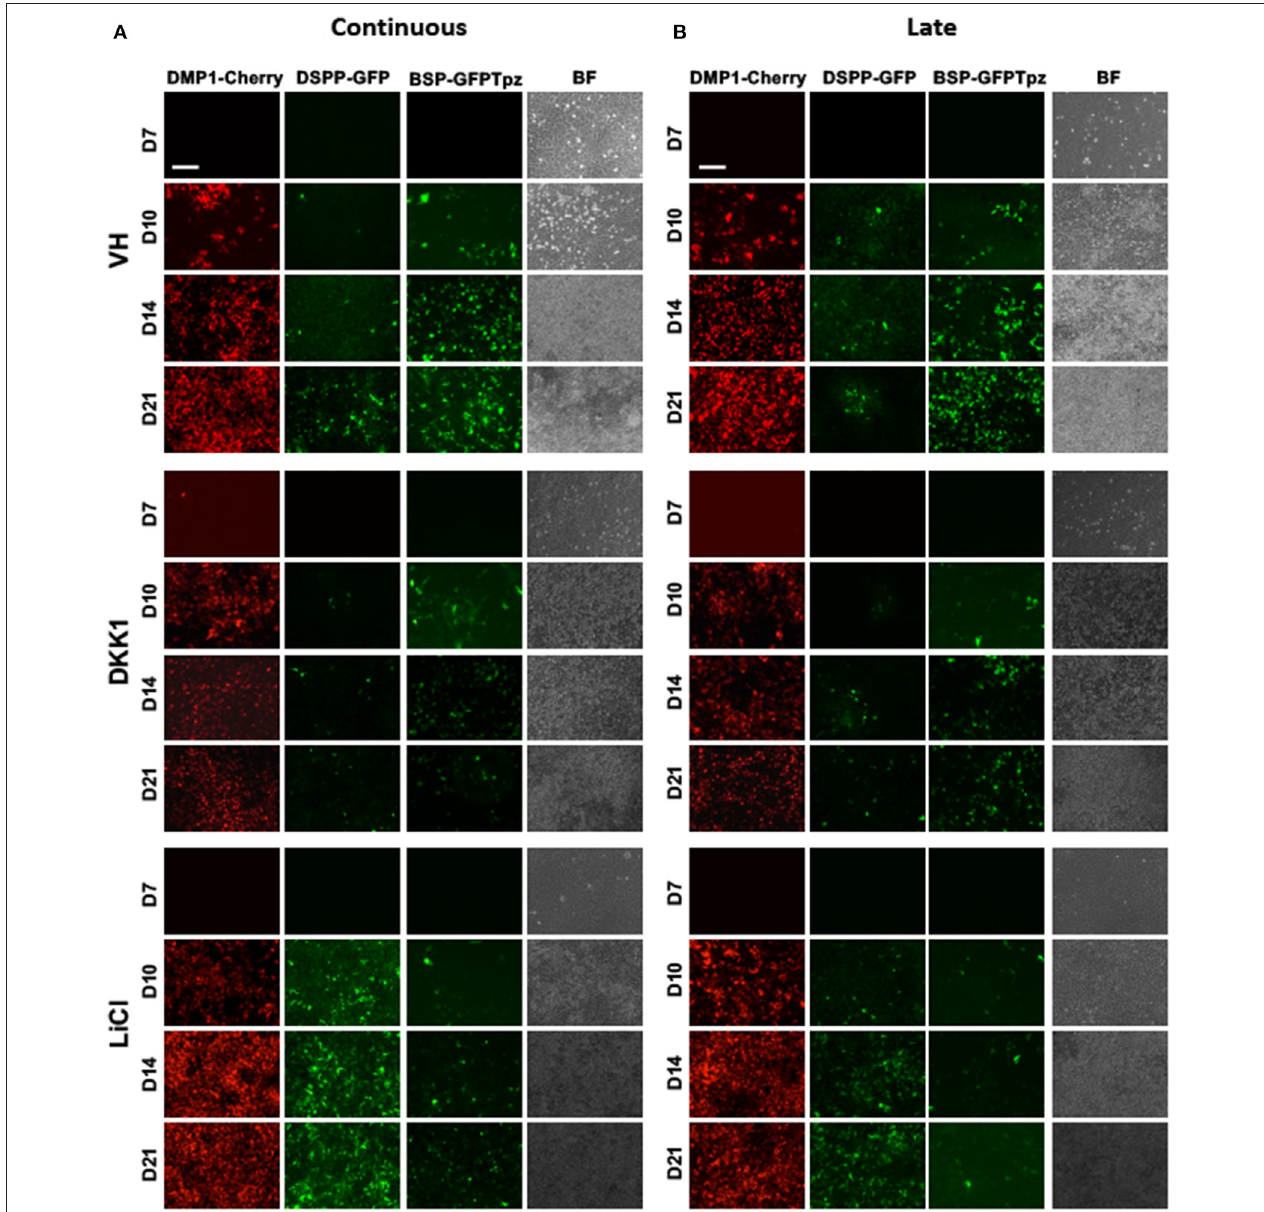
FIGURE 4 | Effects of continuous and late exposure of LiCl and DKK1 on tissue- and stage-specific reporters by epifluorescence imaging. Primary pulp cultures were treated continuously between days 3 and 21 (A) and late between days 7 and 21 (B) with VH (0.1% BSA), DKK1 (50ng/ml) and LiCl (10mM). (A,B) Representative images of the cultures from DMP1-Cherry/DSPP-Cerulean and BSP-GFPtpz transgenic mice treated with VH, DKK1, and LiCl continuously (A) , and late (B) analyzed under brightfield (BF) and epifluorescent light for the detection of DMP1-Cherry, DSPP-GFP, and BSP-GFPtpz. Continuous and late exposures to LiCl increased DMP1-Cherry and DSPP-GFP expression, which were decreased in DKK1 treated cultures. Continuous and late LiCl and DKK1 treatments decreased BSP-GFPtpz expression. Scale bar = 200 µ